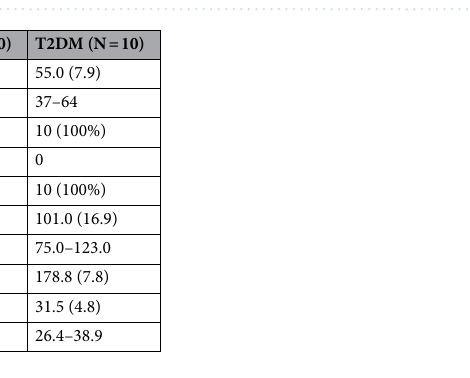
Figure 2. OGTT glucose ( left ) and proinsulin:c-peptide (PC) ratio profile ( right ) for subjects included into the study (N = 30). Graphs are colored by health group.